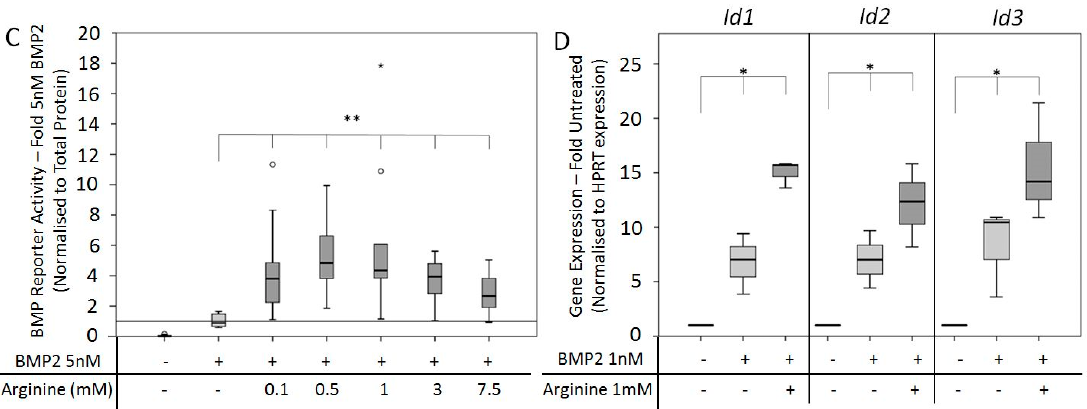
Figure 1. Bone morphogenetic protein (BMP) reporter activity and BMP target gene expression after stimulation with the nitric oxide synthase (NOS) substrate Arginine. C2C12BRELuc cells stimulated